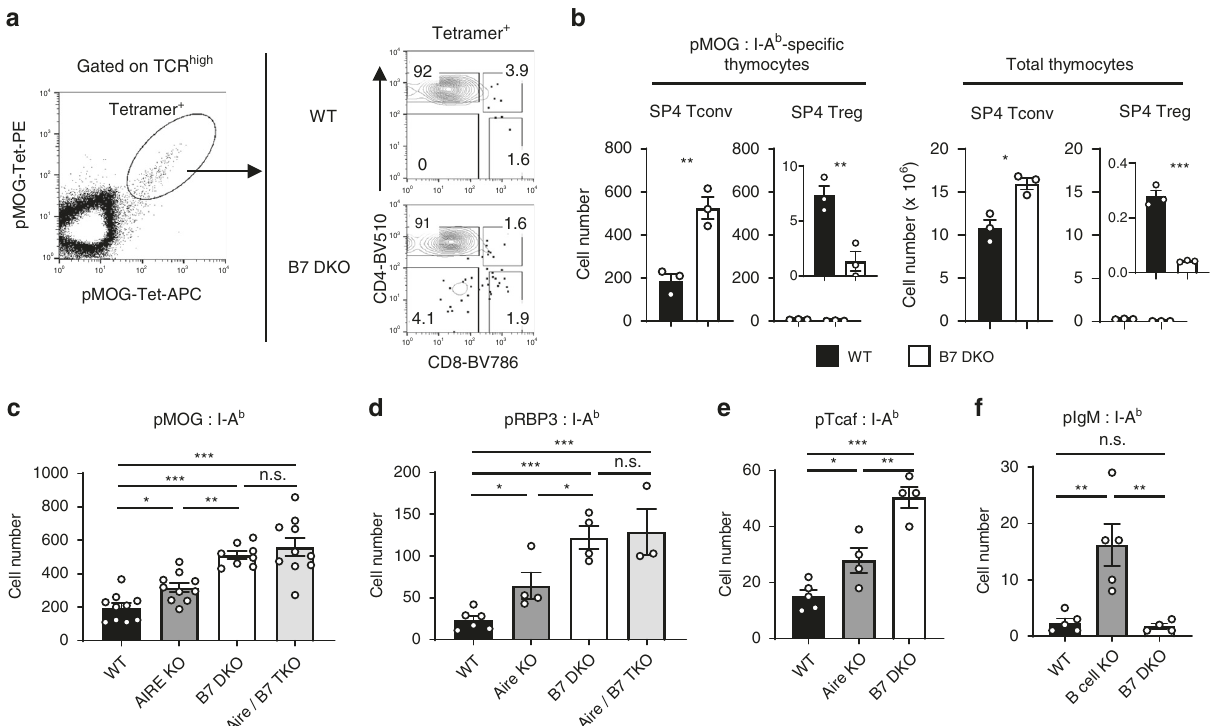
Fig. 3 B7-CD28 co-stimulation is required for clonal deletion of TRA-speci fi c polyclonal SP4 thymocytes. a Tetramer detection of pMOG-speci fi c thymocytes in WT and B7 DKO mice. b pMOG-speci fi c SP4 Tconv thymocyte number was increased in B7 DKO mice. Each group n = 3. Data are representative of three independent experiments. pMOG SP4 Tconv p = 0.0048, pMOG SP4 Treg p = 0.0086, total SP4 Tconv p = 0.0111, total SP4 Treg p = 0.0004. c pMOG-speci fi c SP4 Tconv thymocyte number in B7 and/or Aire de fi cient mice. WT n = 10, Aire KO n = 10, B7 DKO n = 8, Aire B7 TKO n = 10. Data are pooled results of at least three independent experiments. WT and Aire KO p = 0.0206, WT and B7 DKO p < 0.0001, WT and Are / B7 TKO p < 0.0001, Aire KO and B7 DKO p = 0.0016. d pRBP3-s p eci fi c SP4 Tconv thymocyte number in B7 and/or Aire de fi cient mice. pRBP3-speci fi c CD4SP Tconv thymocyte number was increased in B7 DKO mice. WT n = 6, Aire KO n = 4, B7 DKO n = 4, Aire B7 TKO n = 3. Data are pooled results of at least three independent experiments. WT and Aire KO p = 0.0443, WT and B7 DKO p = 0.005, WT and Aire/B7 TKO p = 0.005, Aire KO and B7 DKO p = 0.0271. e pTcaf3-s p eci fi c SP4 Tconv thymocyte number in B7 and/or Aire de fi cient mice. pTcaf3-speci fi c CD4SP Tconv thymocyte number was increased in B7 DKO mice. WT n = 5, Aire KO n = 4, B7 DKO n = 4. Data are pooled results of at least three independent experiments. WT and Aire KO p = 0.0228, WT and B7 DKO p < 0.0001, Aire KO and B7 DKO p = 0.0023. f Clonal deletion of p IgM-speci fi c CD4SP Tconv thymocytes was intact in B7 DKO mice. WT n = 5, B cell KO n = 5, B7 DKO n = 4. Data are pooled results of at least three independent experiments. WT and B cell KO p = 0.0038, WT and B7 DKO p = 0.0042. b – e Data are mean ± SEM with dots r e presenting individual values of biologically independent animals. Statistical differences between groups were calculated using unpaired, two-tailed Student ’ s t -test. * p < 0.05, ** p < 0.01, *** p < 0.001. Source data are provided as a Source Data fi